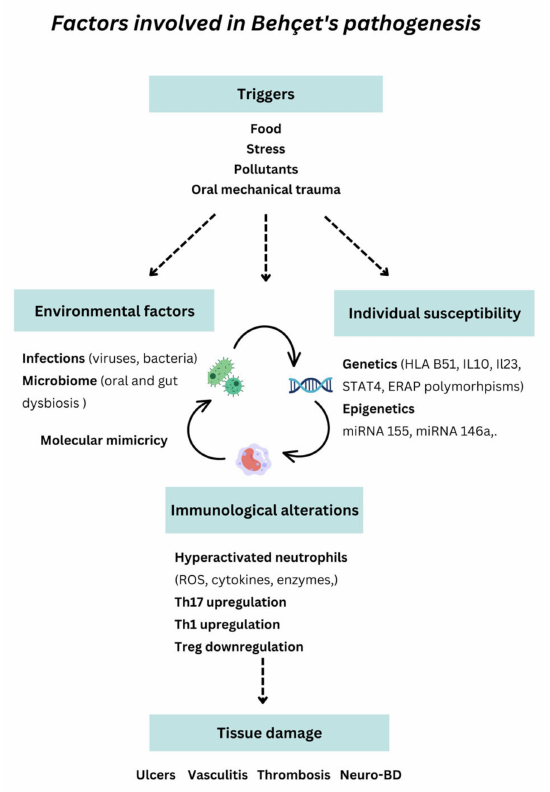
Figure 4. Mechanisms underlying Behçet’s disease’s